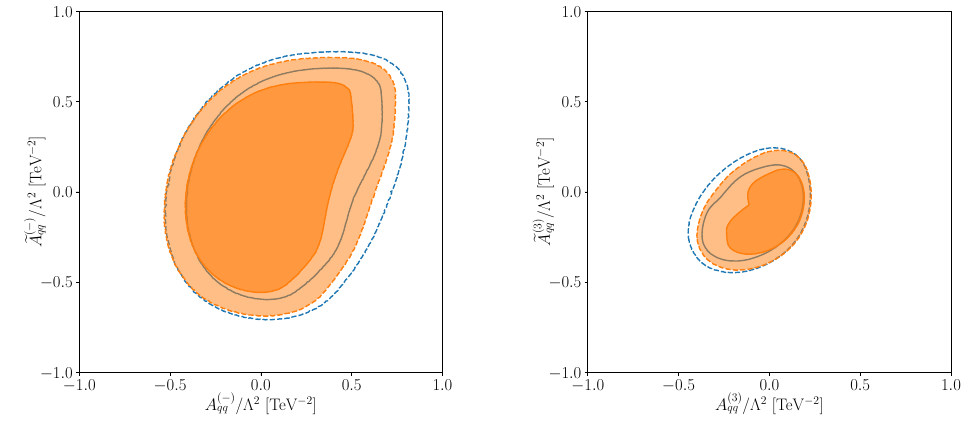
Figure 8 . Flavor contractions in the four-quark coefficients C ( − ) qq ( m t ) = C (1) qq − C (3) qq (left) and C (3) ( m ) (right) in MFV. Shown are the bounds obtained from a four-parameter fit of qq t { A ( − ) qq , e A ( − ) qq , A (3) qq , e A (3) qq } to top (blue) and top & B s → µ + µ − (orange) data at ∆ χ 2 = 2 . 30 (solid) and ∆ χ 2 = 5 . 99